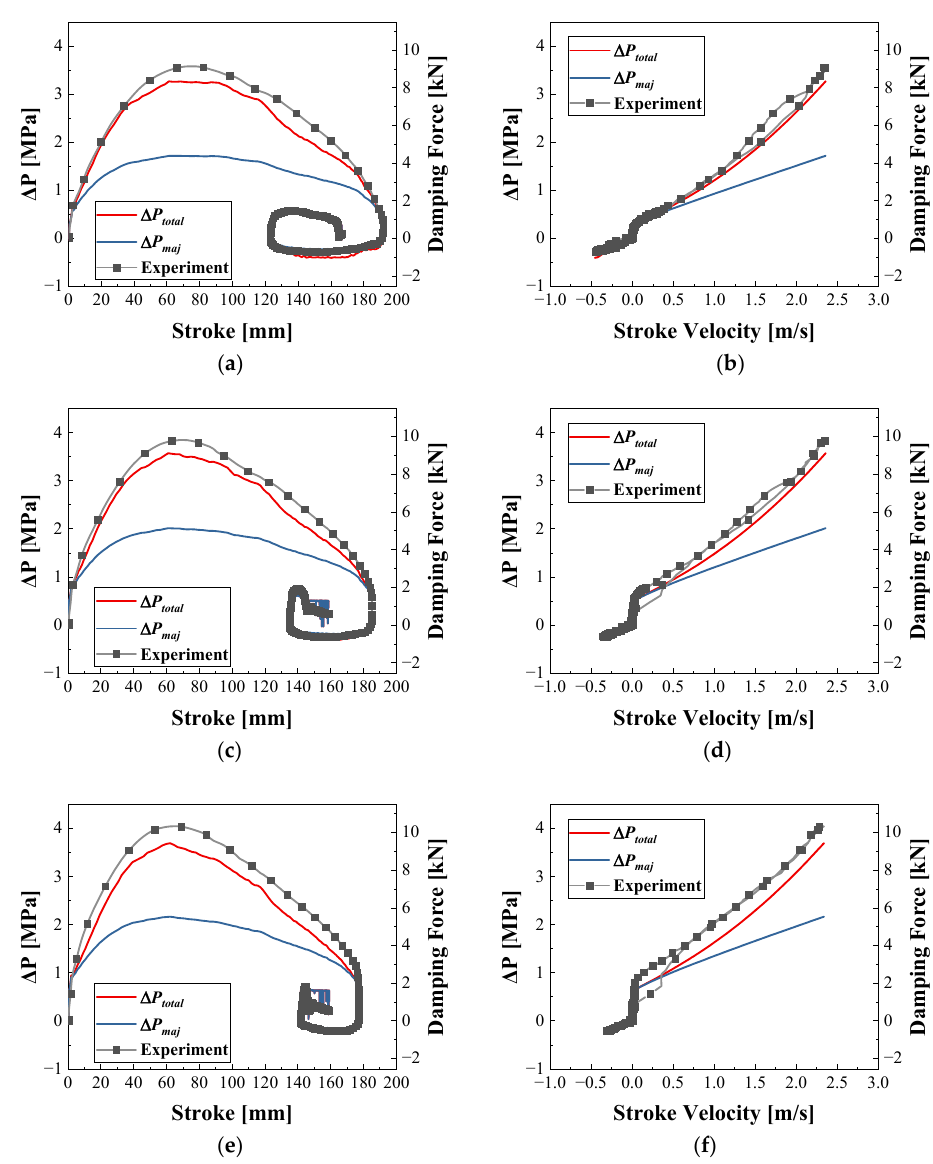
Figure 8. Pressure drop and estimated damping force considering ∆ P total and ∆ P maj models and experiment data: ( a ) for stroke and input current of 0.5 A; ( b ) for stroke velocity and input current of 0.5 A; ( c ) for stroke and input current of 1.0 A; ( d ) for stroke velocity and input current of 1.0 A; ( e ) for stroke and input current of 1.5 A; ( f ) for stroke velocity and input current of 1.5 A. Table 3. Dissipated energy in MR shock absorber for input current; RMS values of error for model-based and measured pressure data over a stroke velocity range of 0.1 m/s or more.